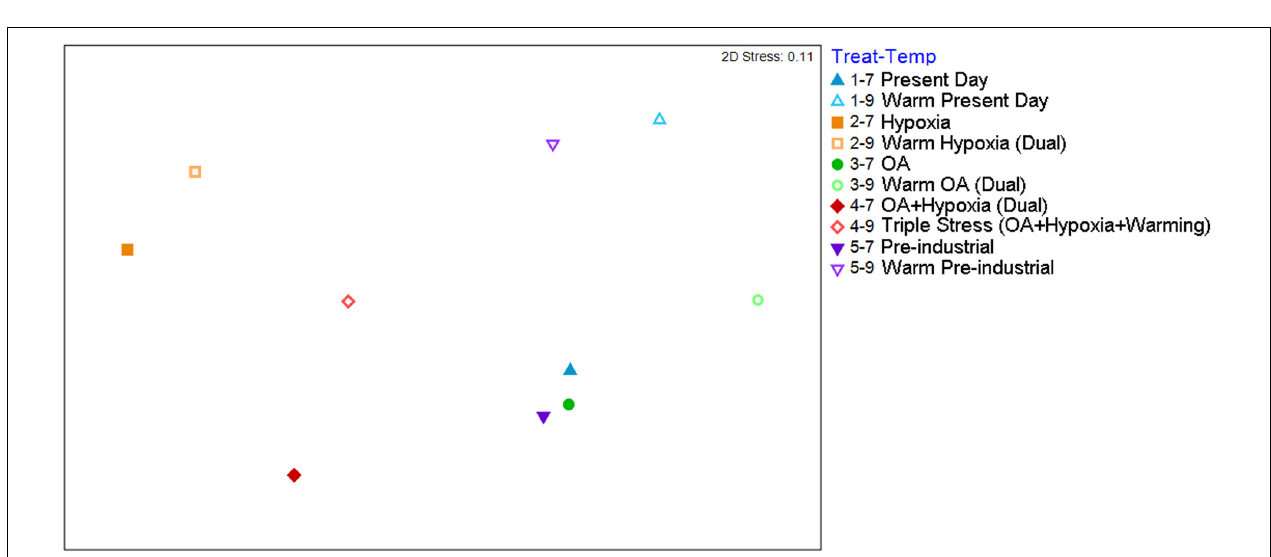
FIGURE 4 | Two-dimensional nMDS plot of the 7C Total 9C Live dataset presented as the grand average of the four containers for each sub-treatment. Treatment 1 (blue) is Present Day; Treatment 2 (orange) is Hypoxia; Treatment 3 (green) is OA; Treatment 4 (red) is OA + Hypoxia; Treatment 5 (purple) is Pre-industrial. Filled symbols represent 7 ◦ C samples; open symbols represent 9 ◦ C